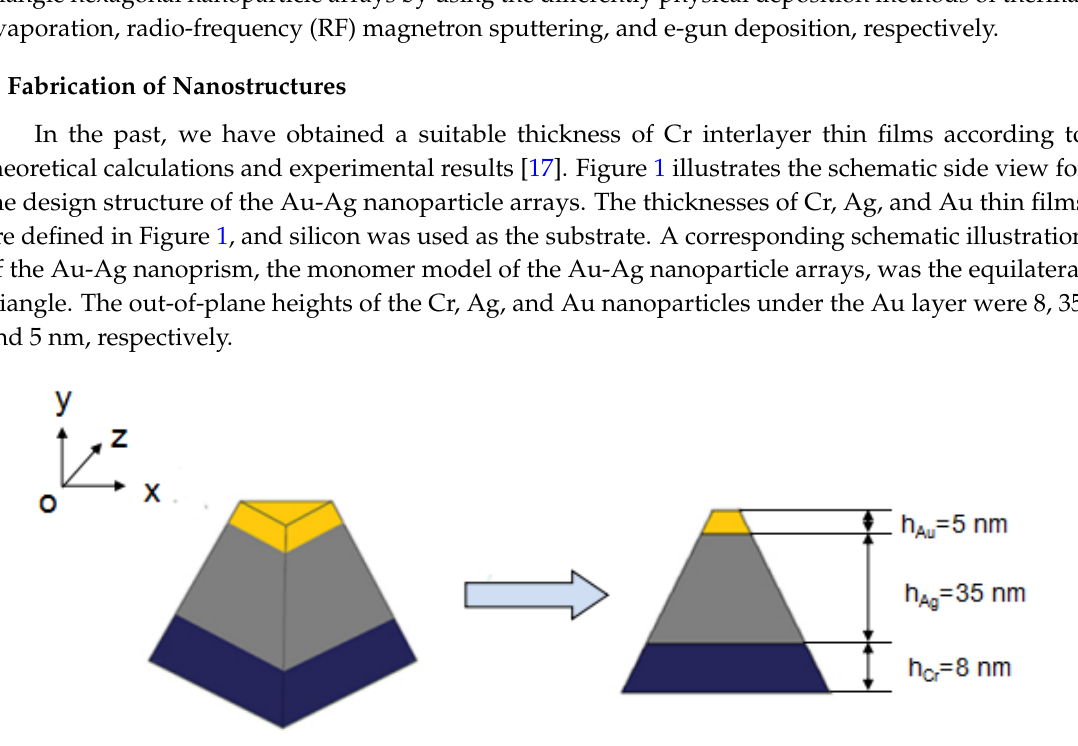
Figure 1. A monomer model of the triangle Ag nanoparticle arrays in 3D view and side cross-section